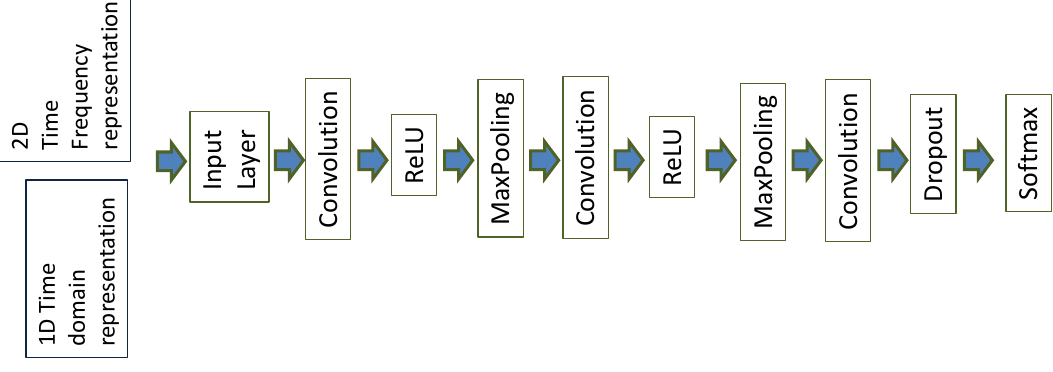
Figure 9. CNN architectureused for the